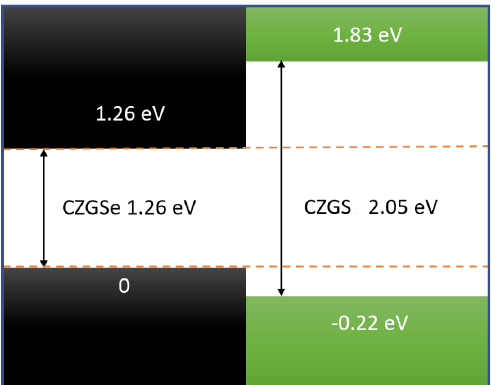
Figure 7. Schematic view of the band discontinuity of CZGS/CZGSe